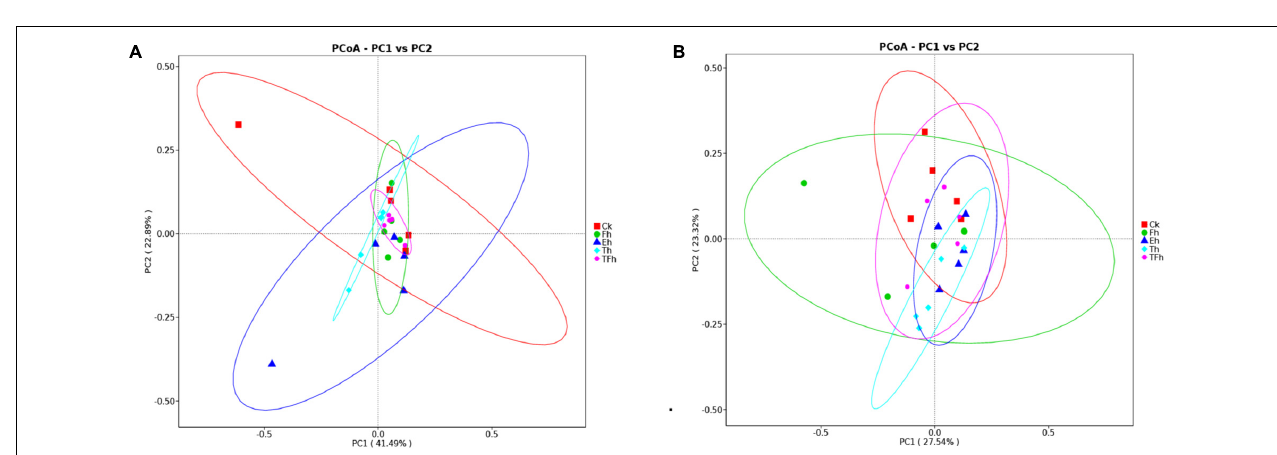
FIGURE 2 | The alpha-diversity based on ACE (A) , Chao 1 (B) , Shannon (C) , and Simpson (D) indices of the gut microbial community of E. grisescens . Significant differences were detected using unpaired two-tailed t -tests. CK: no starvation treatment; Fh: 4 h starvation treatment; Eh: 8 h starvation treatment; Th: 12 h starvation treatment; TFh: 24 h starvation treatment.